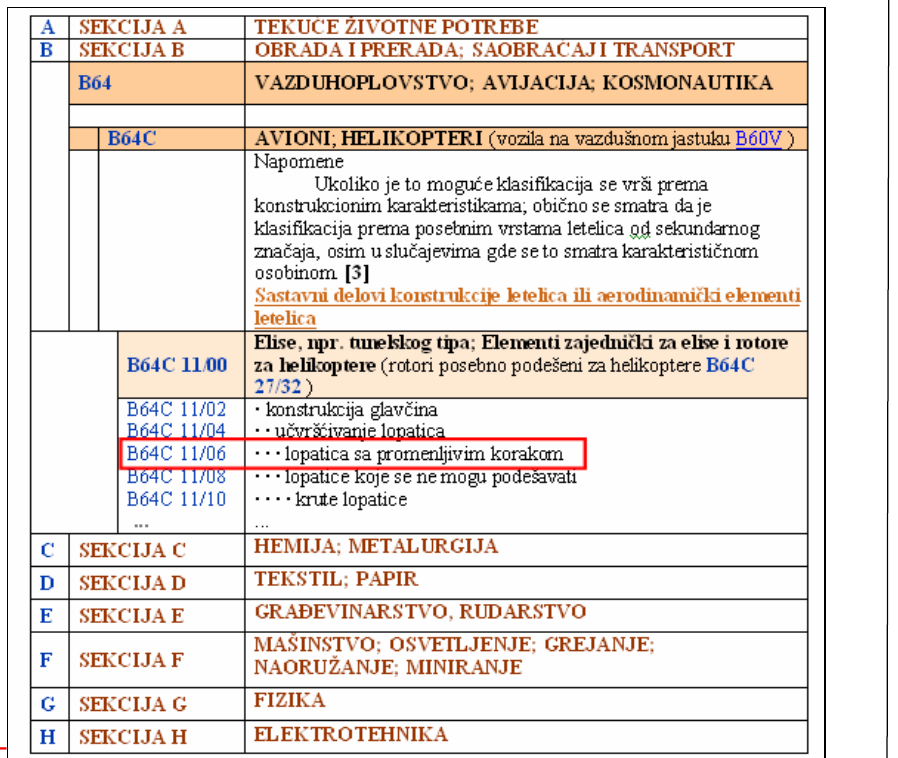
Tabela 1 – Struktura IPC oznake Table 1 – Structure of the IPC code Таблица 1 – Схема IPC